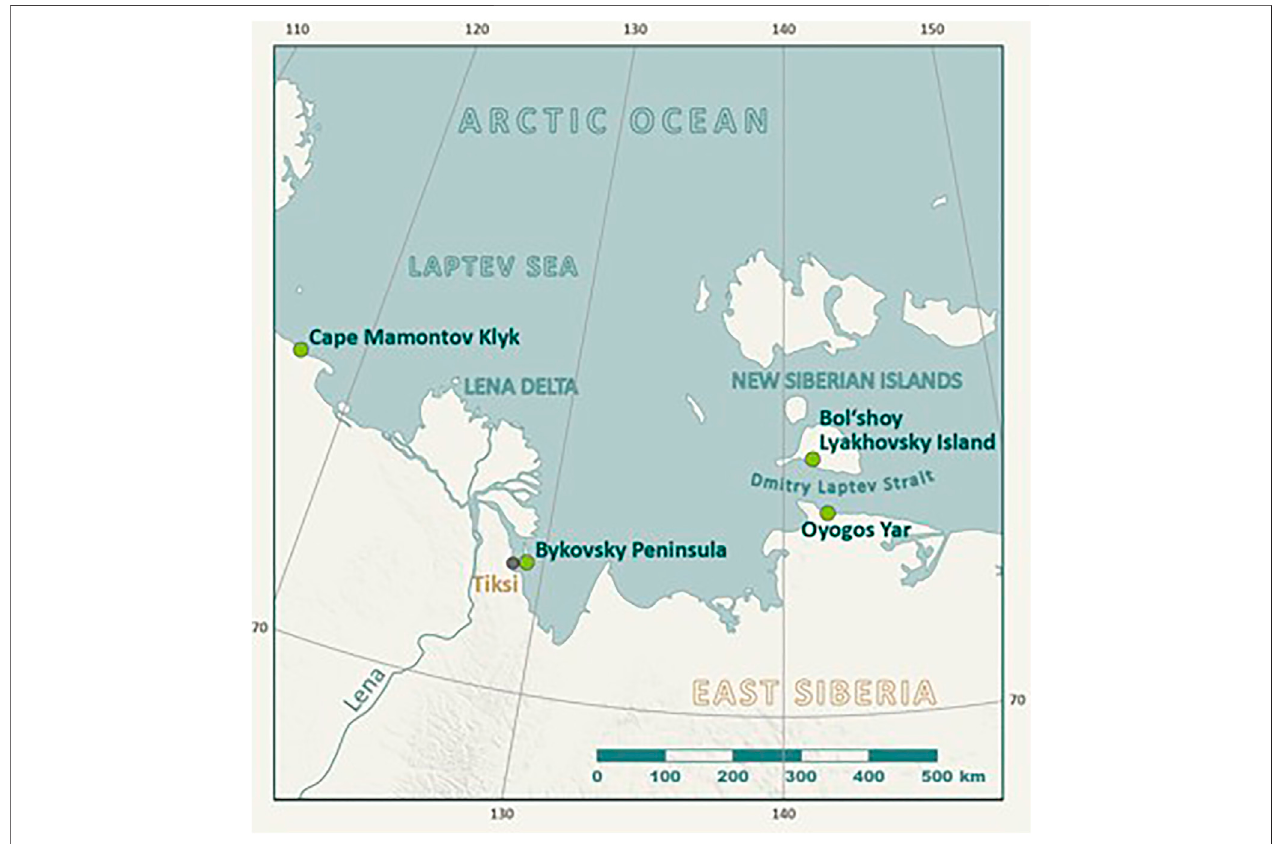
FIGURE 1 | Study region in the East Siberian Arctic showing the Oyogos Yar study site and other relevant study sites on the New Siberian Archipelago (Bol ’ shoy Lyakhovsky Island) and at the shore of the Laptev Sea (Cape Mamontov Klyk, Bykovsky Peninsula, and Lena Delta) mentioned in the paper.